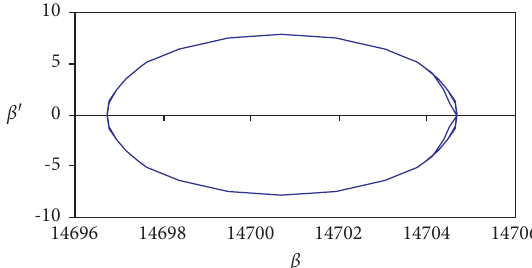
Figure 17: The stability phrase β ′ and β for case (i) in Section 4.2.